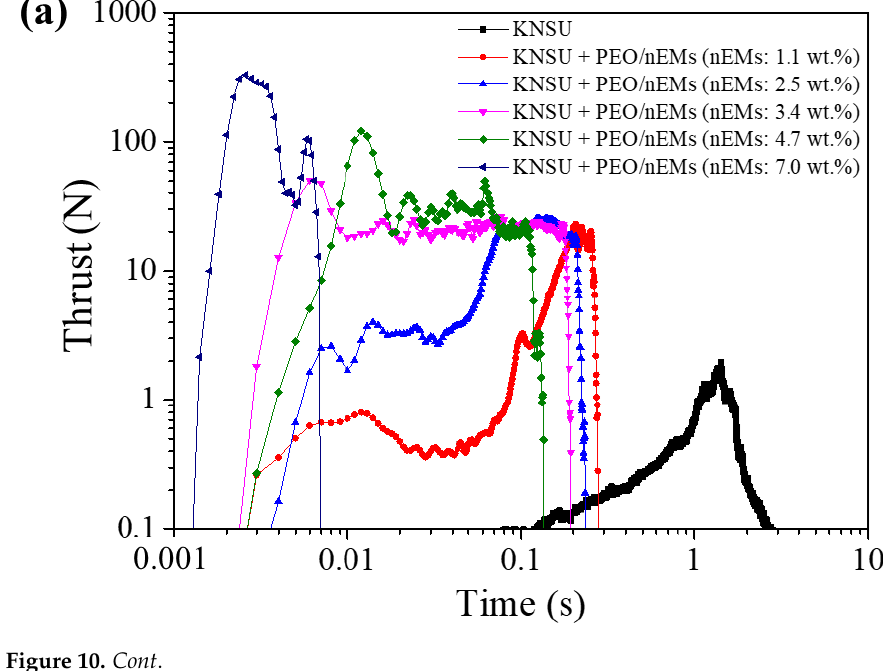
Figure 10. ( a ) Thrust traces and ( b ) specific impulses of KNSU/PEO/nEM-based 3D CSPs incorpo- rated with various nEM contents (Inset shows the specific values of propulsion characteristics of KNSU/PEO/nEM-based 3D CSPs, where T max : maximum thrust, t: thrust duration, I total : total im- pulse, and I sp : specific impulse). 4. Conclusions In this study, 3D PEO/nEM composite structures were successfully fabricated using additive manufacturing, which enabled the uniform distribution of Al NPs (fuel), CuO NPs (oxidizer), and PEO (polymer binder). First, when the PEO content was ≤5 wt.%, the PEO/nEM composite 3D structures were easily broken due to the weak chain bonding of the PEO polymer binder. As the PEO content increased (i.e., PEO content > 5 wt.%), the electrical discharge sensitivity of the nEM composites reduced significantly, implying that the handling stability of the as-prepared PEO/nEM composites improved. However, the